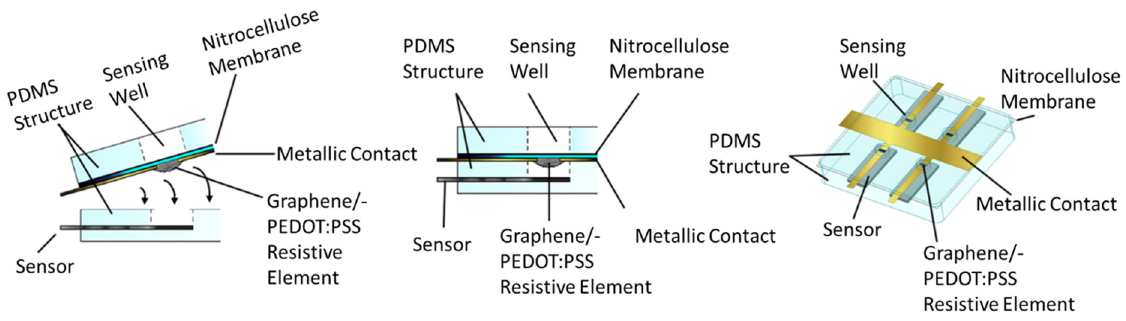
Figure 4. Assembled sensor well, membrane, and filament.